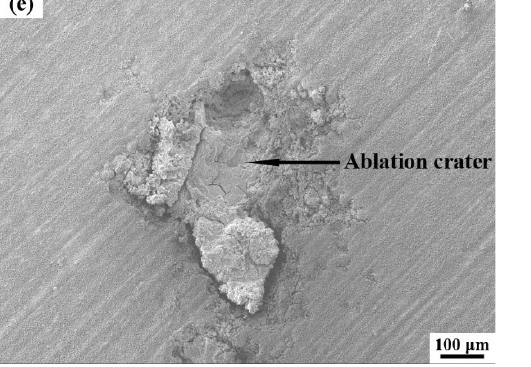
Figure 3. The surface morphology of coatings at the frequency is 500 Hz, the duty cycle is 30% (cooling time is 1.4 ms) and the voltage is ( a ) 150 V, ( b ) 250 V, ( c ) 400 V, for a ( d ) film ablation ( e ) ablation crater, respectively.